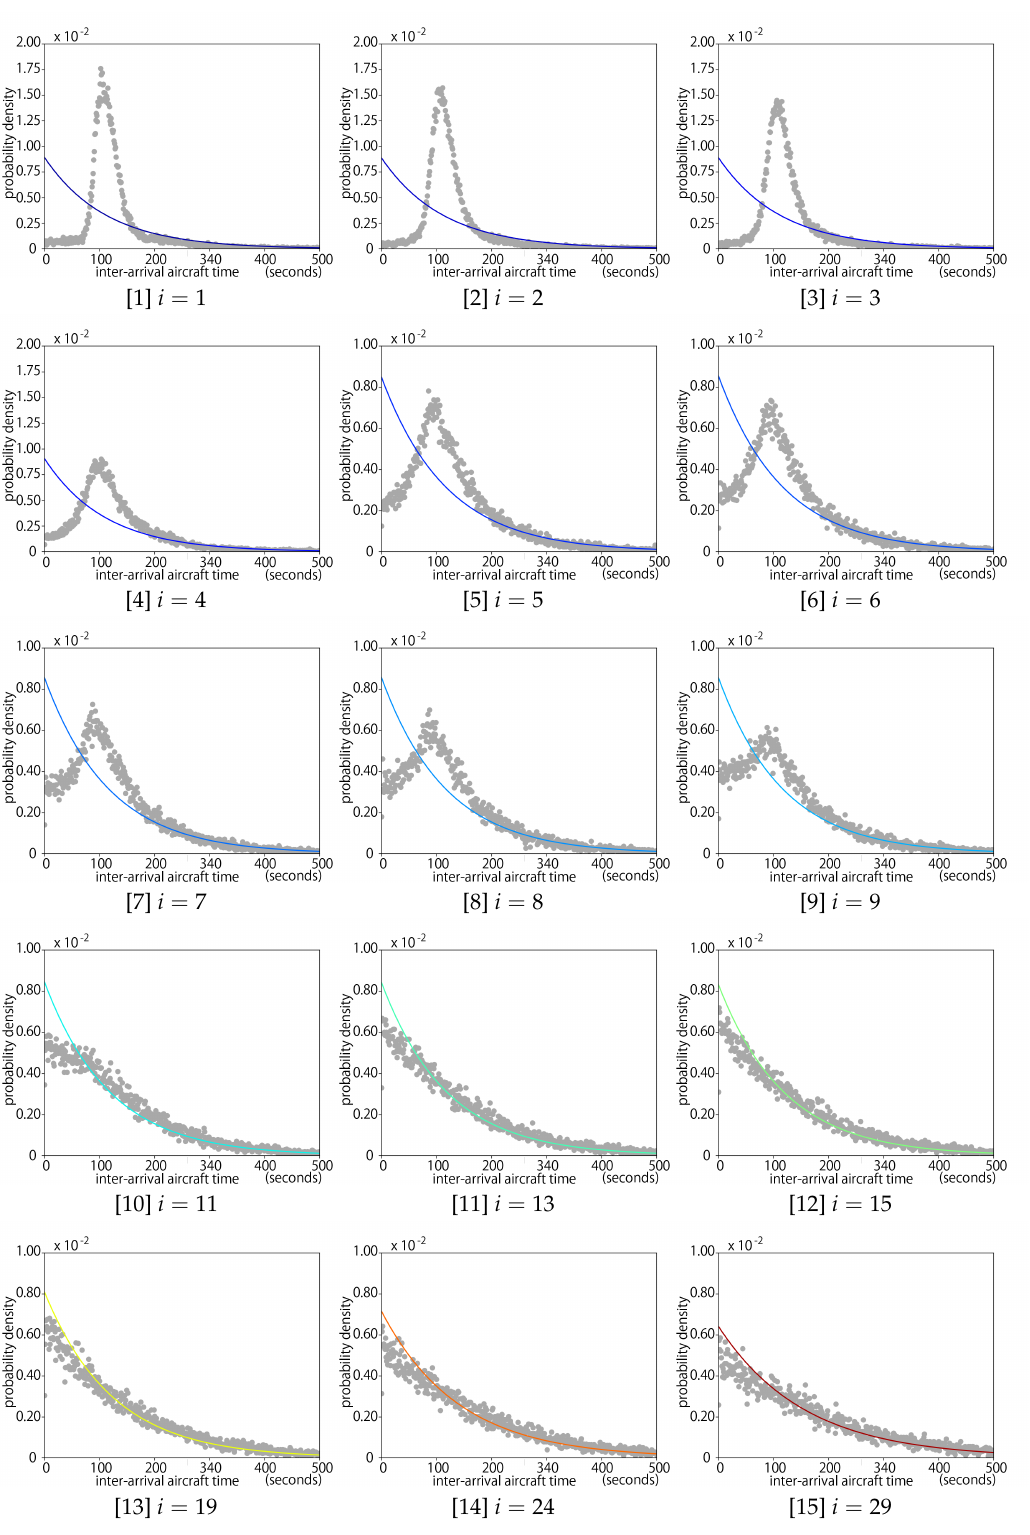
Figure 10. Empirical distribution of the aircraft inter-arrival time and exponential